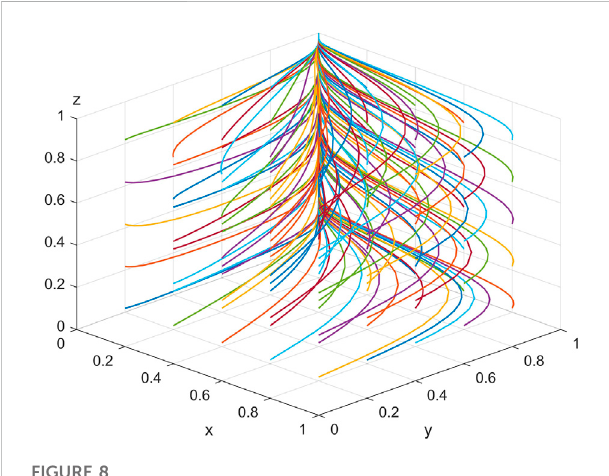
FIGURE 8 System evolution process at a mature stage. FIGURE 9